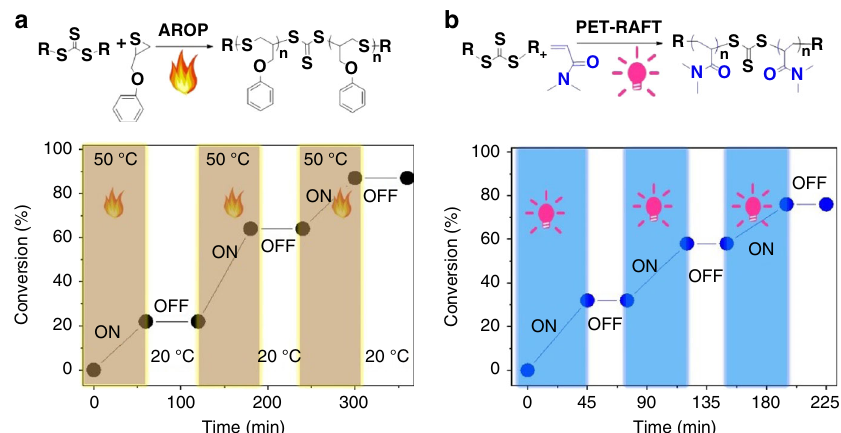
Fig. 2 ON/OFF modes of AROP and PET-RAFT polymerization. a AROP and POMT conversion vs. time with and without heating. b PET-RAFT polymerization and DMA conversion vs. time with and